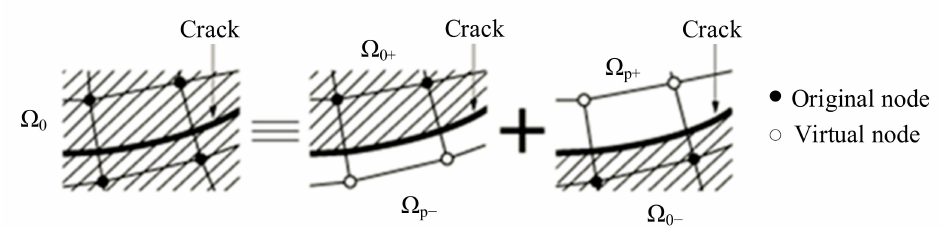
Figure 5. Virtual node